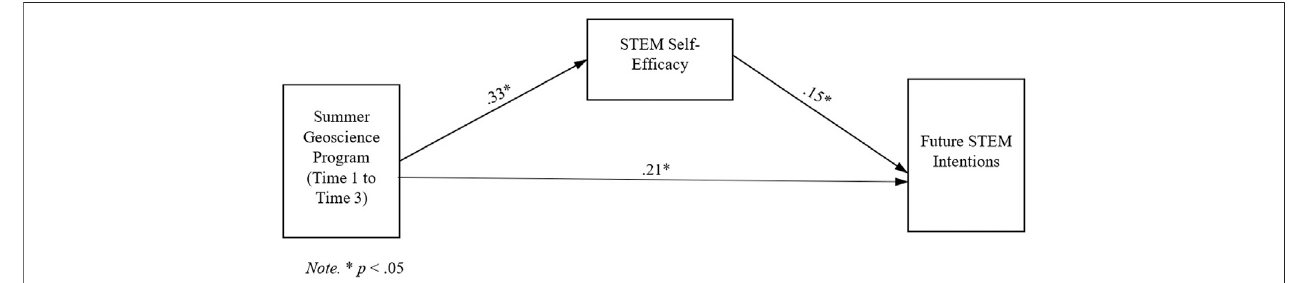
FIGURE 2 | Statistical model depicting effects of the summer geoscience program on future STEM intentions, mediated by STEM self-ef fi cacy.